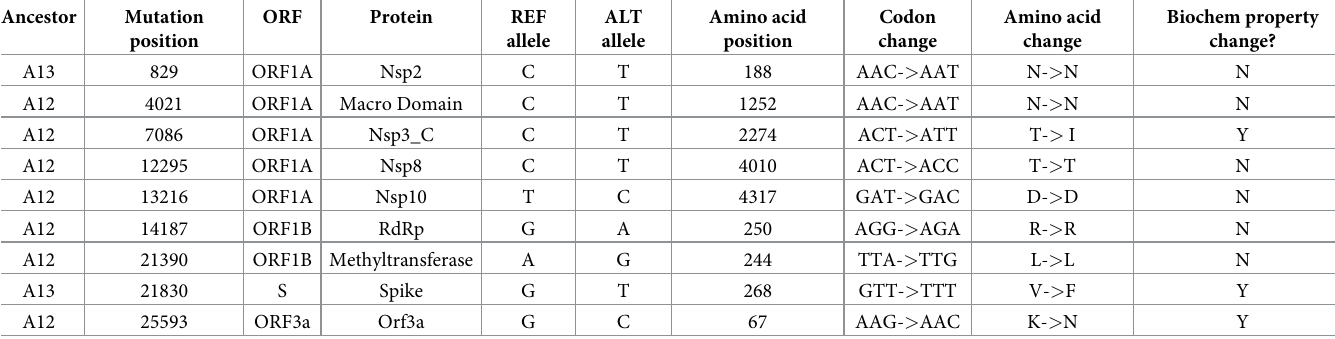
Table 2. Lineage-defining mutations contributing to the Colorado Springs variant [A12-A13]. Ancestor Mutation